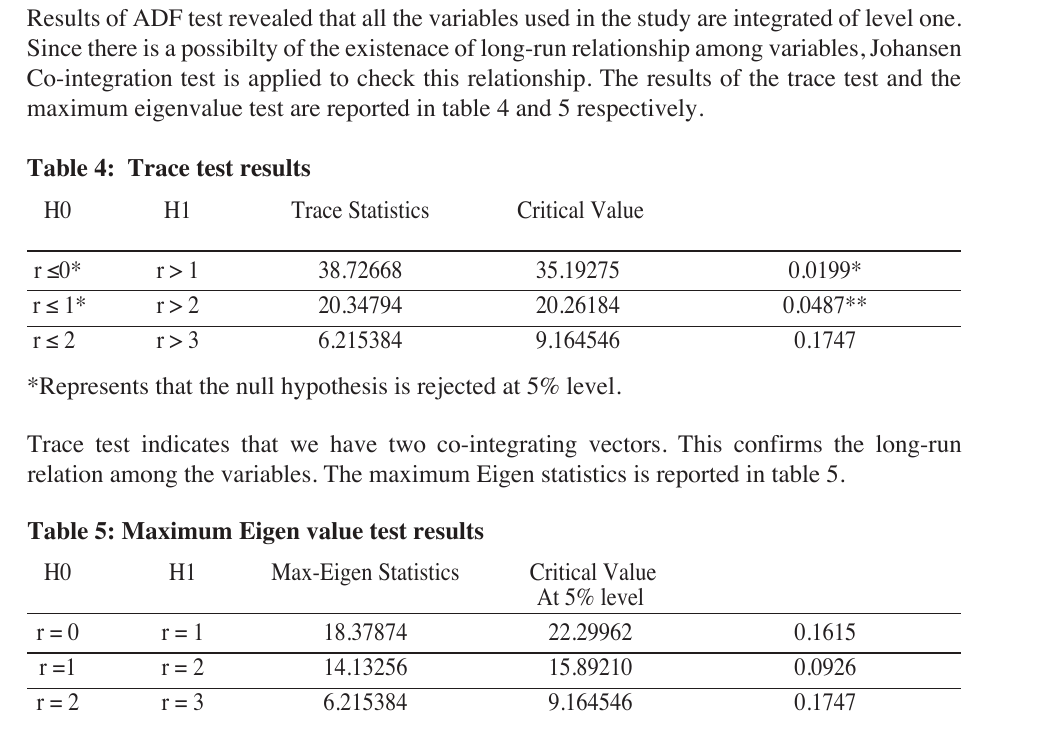
*Represents that the null hypothesis is rejected at 5%